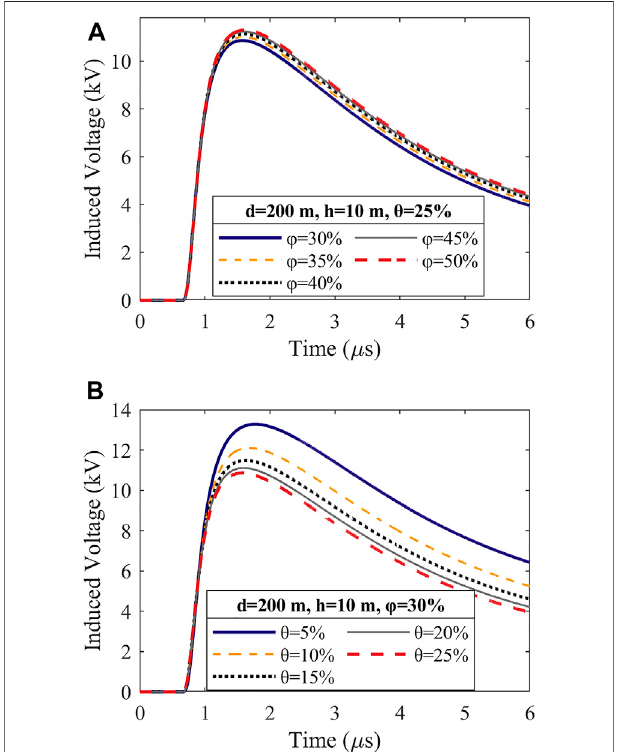
FIGURE 8 | (A) In fl uence of the porosity on LIVs at the near end of the overhead line for high water content θ = 25%. (B) In fl uence of the water content on LIVs at the near end of the overhead line for low porosity φ =